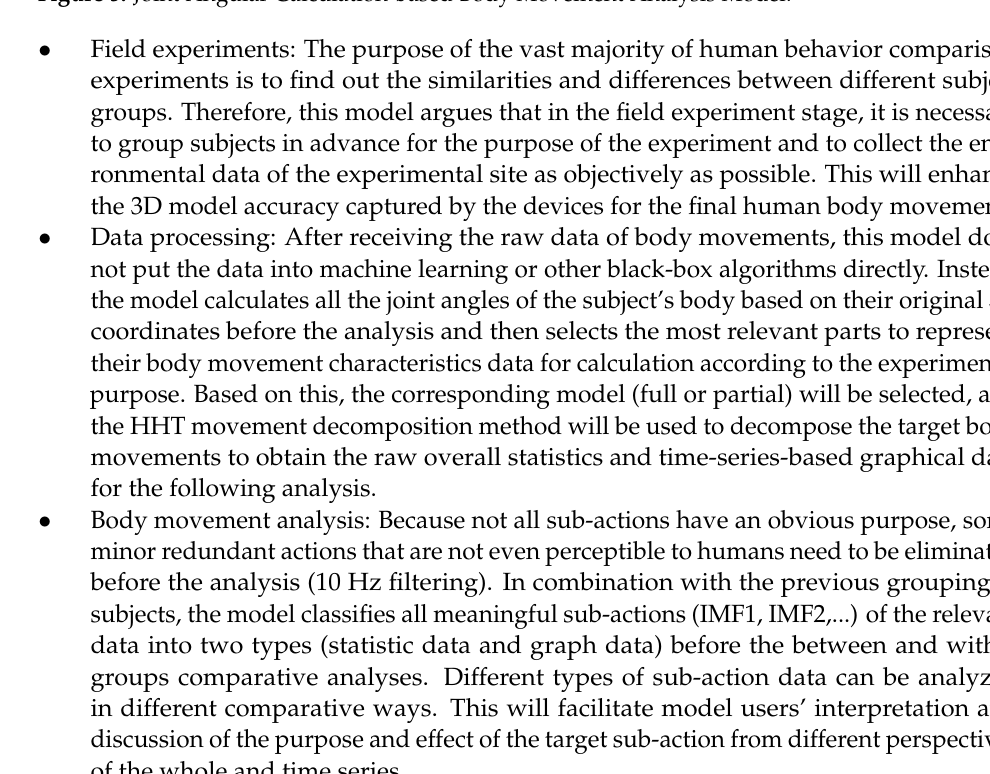
Figure 5. Joint Angular Calculation-based Body Movement Analysis Model.